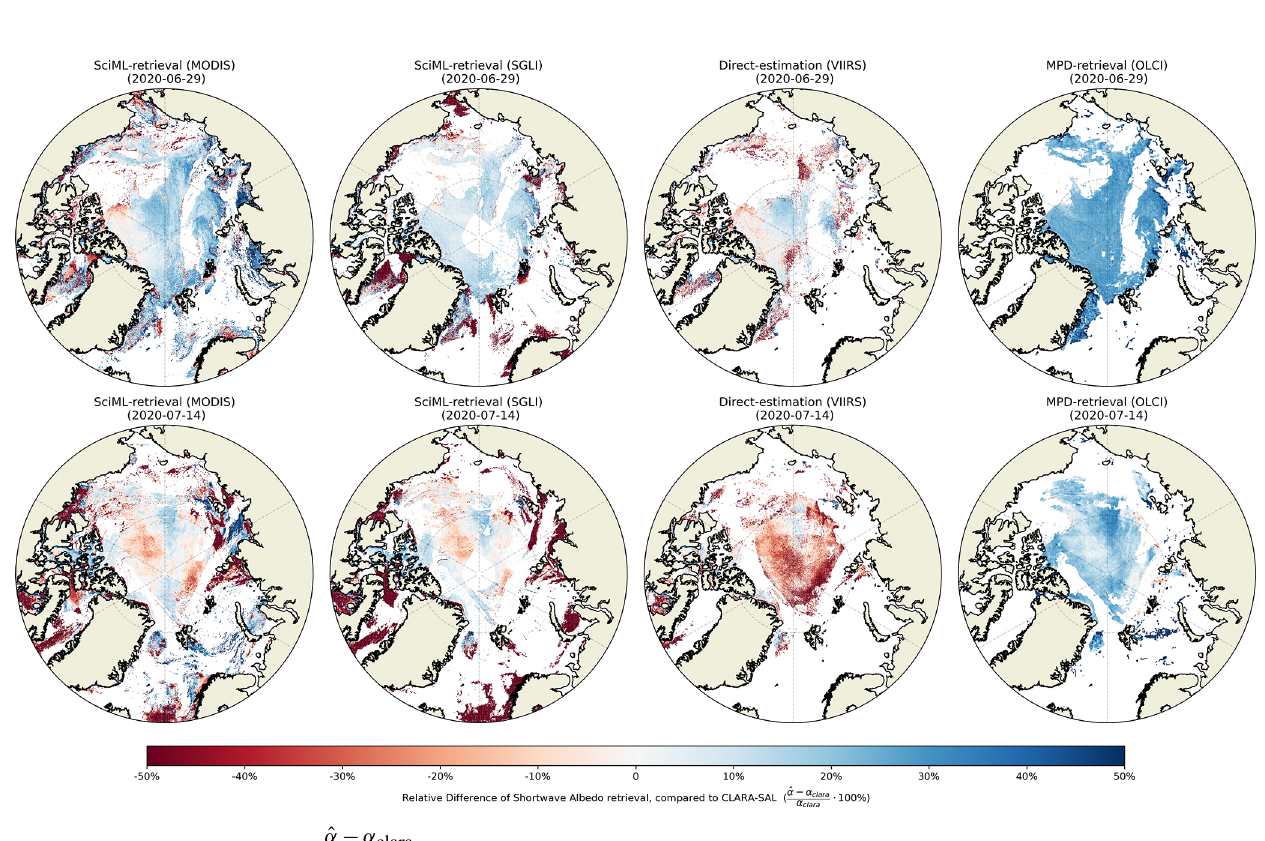
ˆ α − α clara · 100% ) in albedo maps as compared to the CLARA-SAL (Karlsson et al., 2020) results (from Figure B3. Percentage difference ( α clara left to right): RTM–SciML (MODIS), RTM–SciML (SGLI), direct estimation (VIIRS), and MPD (OLCI). The top row represents values for 29 June 2020, while the bottom row represents values for 14 July 2020. Empty regions in SciML images represent cloud pixels that were detected by the MLCM cloud mask, whereas empty regions in VIIRS and OLCI images represent either cloud pixels or open-water areas that were not processed by the